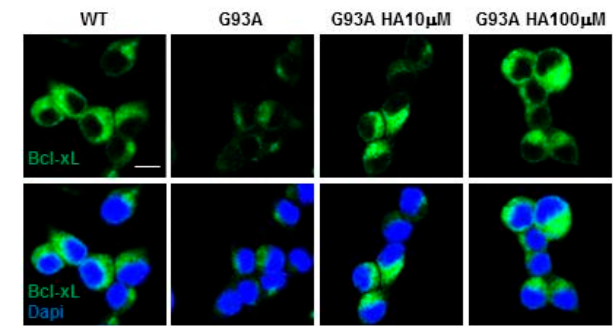
Figure 2. Histamine induces the Heat Shock Response in NSC-G93A motor neuron cells. Representative western blots and quantification of Hsp70 ( A ), GRP78 ( B ), SQSTM1 / p62 ( C ) and Bcl-xL ( D ) in di ff erentiated NSC-WT and NSC-G93A cells treated with histamine (10–100 µ M) for 48 h. GAPDH was used for protein normalization. HA = histamine. Data represent mean ± S.E.M. ( n = 3 independent experiments). Statistical significance was calculated by ANOVA, as referred to NSC-WT cells, # p < 0.05 or to NSC-G93A untreated cells, * p < 0.05; ** p < 0.01. ( E ) Representative immunofluorescence images of Bcl-xL (green) in NSC-WT and NSC-G93A cells treated with histamine (10–100 µ M). Dapi for nuclei staining is shown in blue. Scale bar: 20 µ m.